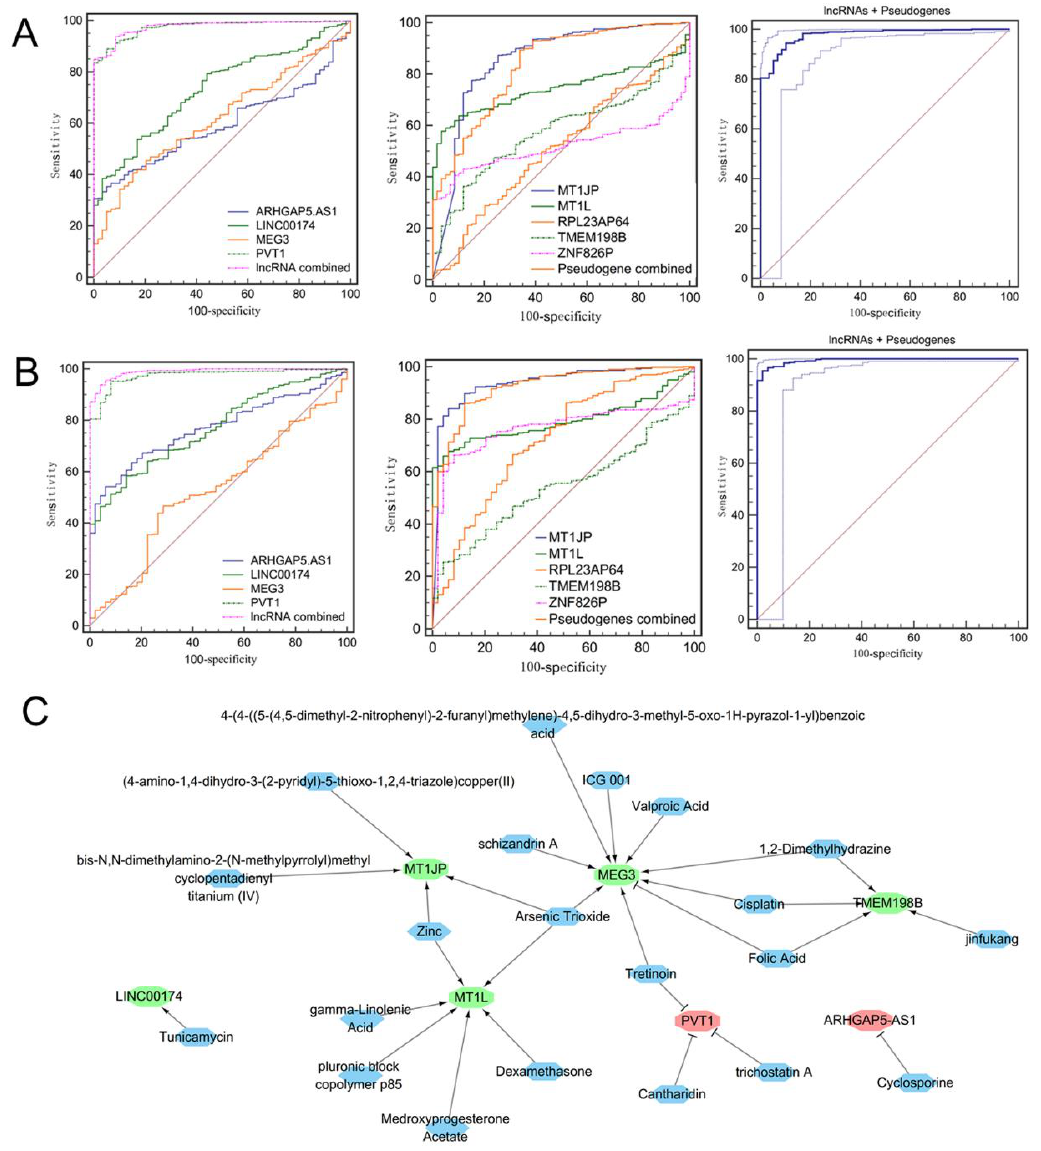
Figure 8. Diagnostic biomarkers and drug targets. ( A , B ) Diagnostic potential analysis of hub lncRNAs and pseudogenes. ( A ) Analysis of LUAD samples in TCGA database; ( B ) analysis of LUSC samples in TCGA database; ( C ) Drugs that reversed the expression levels of hub lncRNAs and pseudogenes in cancer, increased the expression or decreased the expression. Red, upregulated lncRNAs and pseudogenes; green, downregulated lncRNAs and pseudogenes; blue, drugs. LUAD, lung adenocarcinoma; LUSC, lung squamous cell carcinoma; TCGA, the Cancer Genome Atlas.